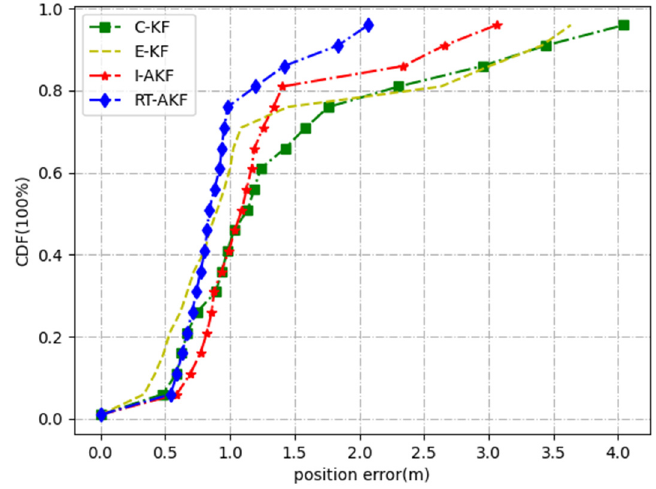
Figure 15. Accuracy comparison by different methods in segment #5.